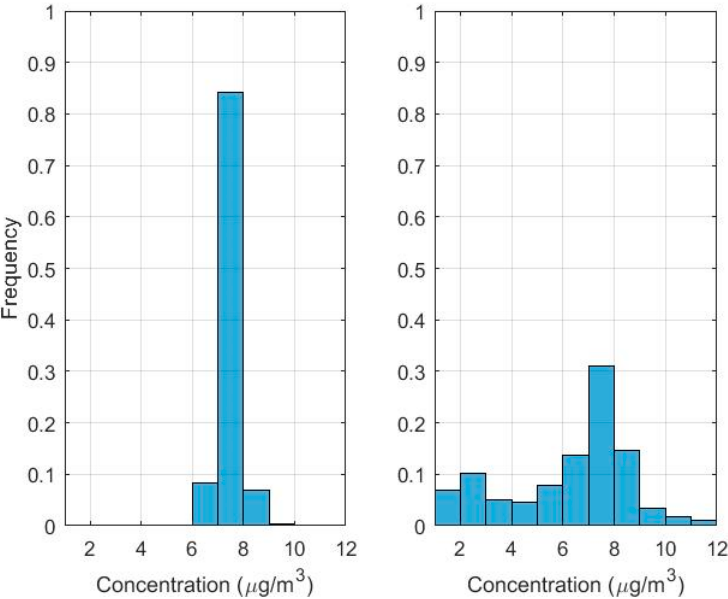
Figure 13. Histograms of PM 2.5 concentrations over the 1000 m resolved receptors used to construct maps in Figure 12, calculated using ( a ) Simple Kriging, left panel, and ( b ) Residual Kriging, right panel.